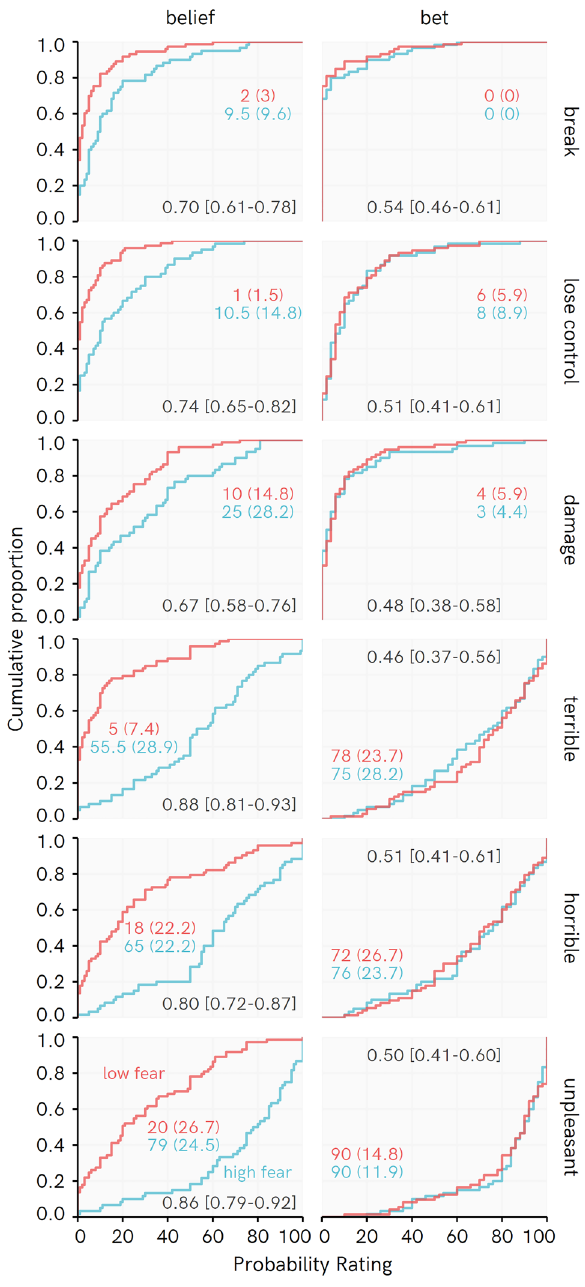
Figure 1. Cumulative distribution for Experiment 1, with raw probability of superiority value and bootstrapped 95% bias corrected accelerated confidence intervals. Colored numbers reflect Median and (Median absolute